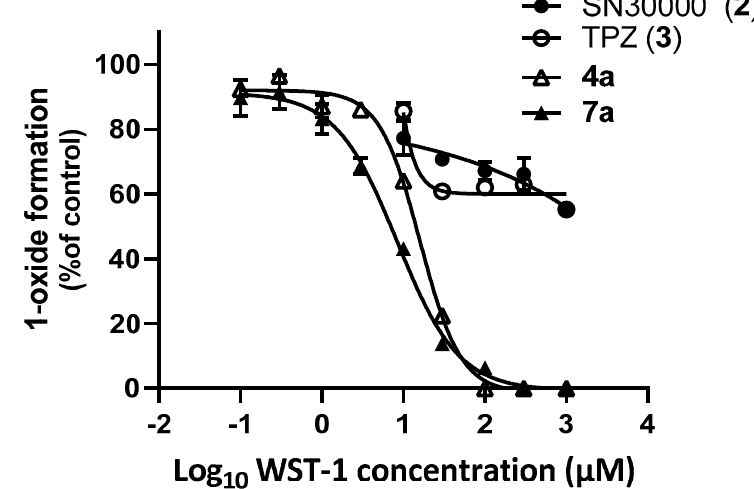
Figure 8. Inhibition of reduction of BTOs to their N- 1-oxides by the cell-excluded electron acceptor WST-1. SiHa cells were seeded in 96-well plates at 10 6 cells / mL and exposed to the compounds (50 µ M) with the indicated concentrations of WST-1 under anoxia for 2 h. Total (pooled intracellular and extracellular) amounts of the 1-oxide metabolites were determined by HPLC. Values are mean and SEM for two experiments with triplicate cultures at each concentration.